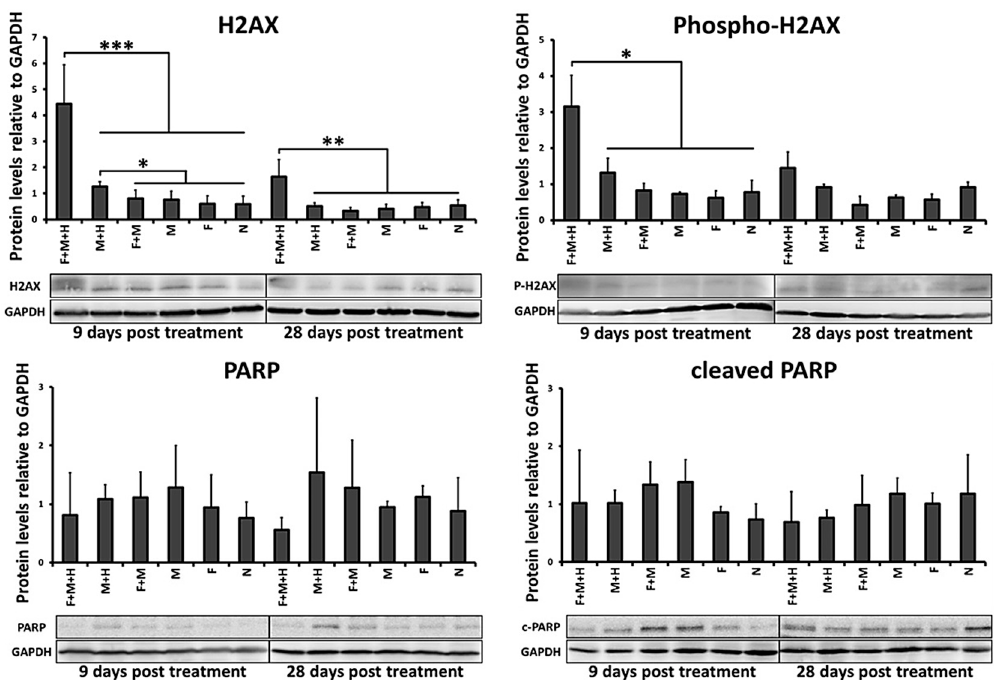
Figure 3. The combinatorial thermo-chemotherapeutic tumor treatment causes greater DNA damages than magnetic hyperthermia alone. Semi-quantitative analysis of protein expression using 3 to 5 independent ex vivo experiments. Representative images of protein bands after Western blot analysis of isolated HT29 xenograft tumor cells at 9 and 28 days after the first magnetic hyperthermia treatment (60 min at H = 15.4 kA/m, f = 410 kHz). GAPDH was used as loading control. F + M + H: combinatorial treatment group (5FU-MNP / MH); M + H: magnetic hyperthermia treatment alone group (MNP /